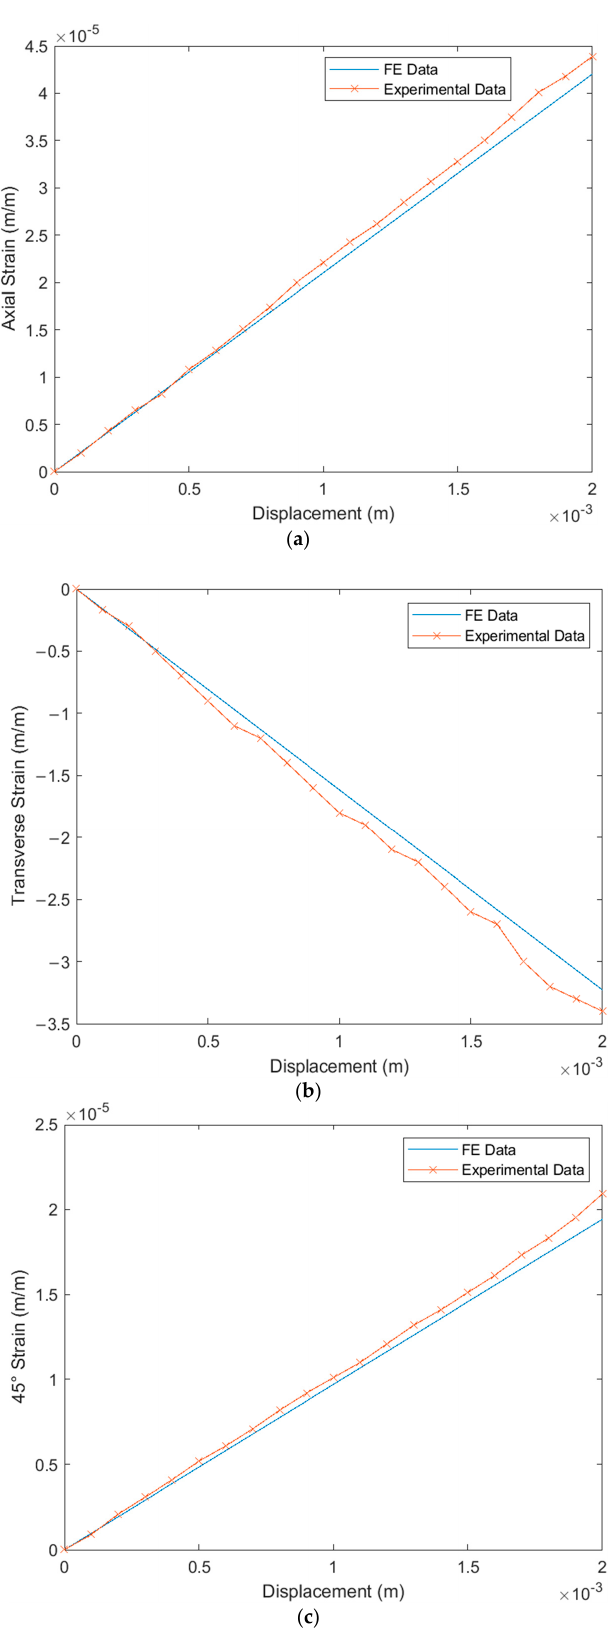
Figure 14. Verification of FE simulation strains (m/m) and experimental strains (m/m) due to tip displacements (µm): ( a ) axial strain ( ε c ); ( b ) transverse strain ( ε a ); ( c ) strain at 45° ( ε b ).